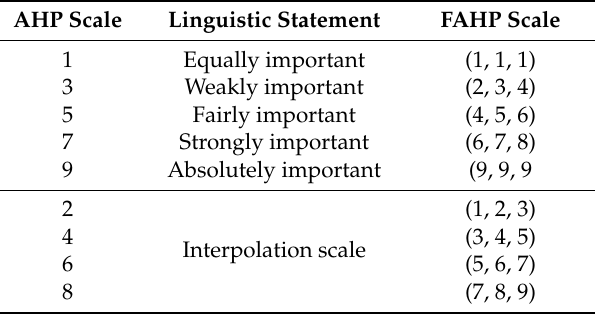
Table 1. Definition of FAHP scale.